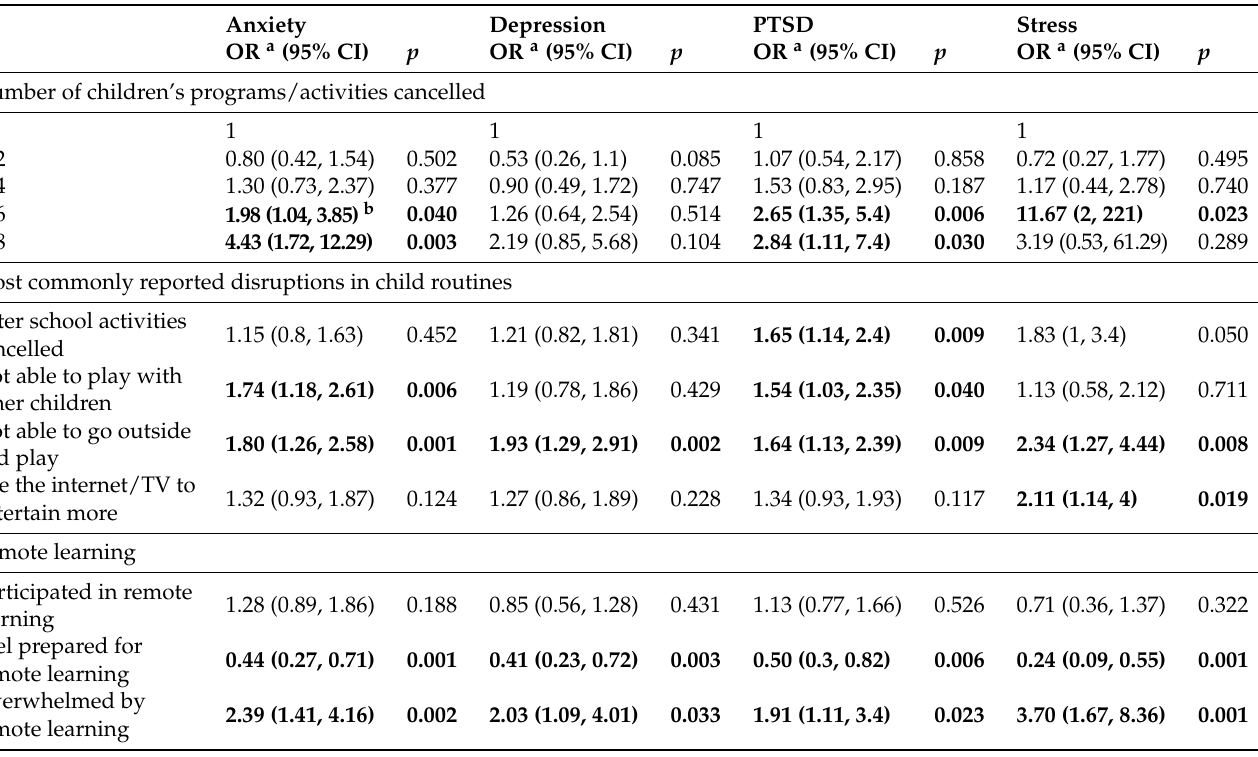
Table 2. Associations between the impact of the pandemic upon children’s lives and parent’s mental health symptoms, unadjusted